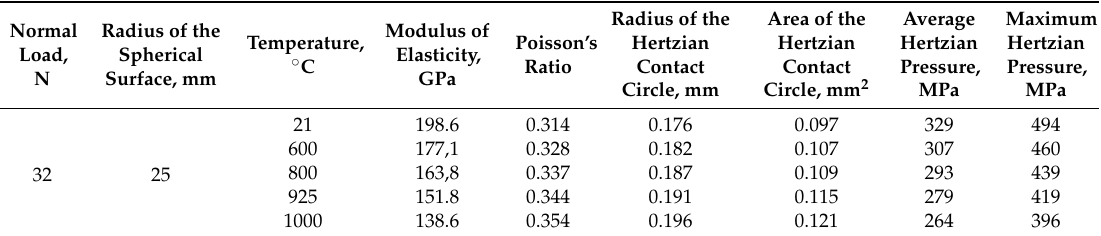
Table 2. Hertzian